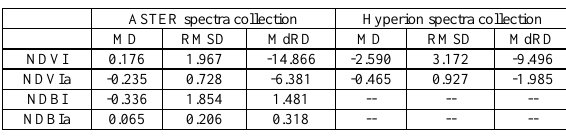
Table 3. Same as Table 2, but for two derived spectra indices (NDVI and NDBI). Both negative and positive spectra index records are included. (Index labelled with “a” is that the corresponding index for MSI is obtained by using “8a” NIR)